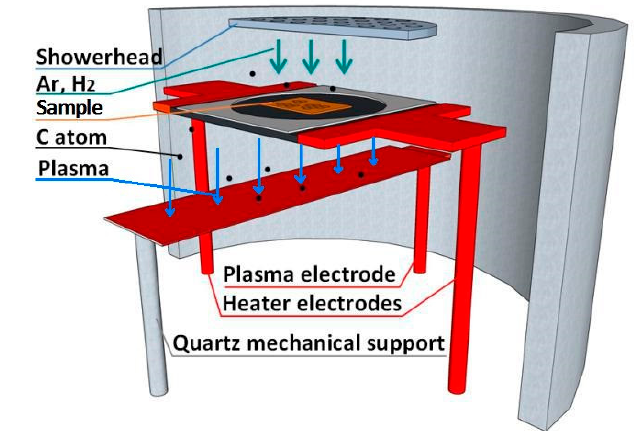
Figure 1. Schematic illustration of the growth chamber of the plasma enhanced chemical vapor deposition (PECVD) equipment which is used for the glow discharge (GD) synthesis of graphene in this work.